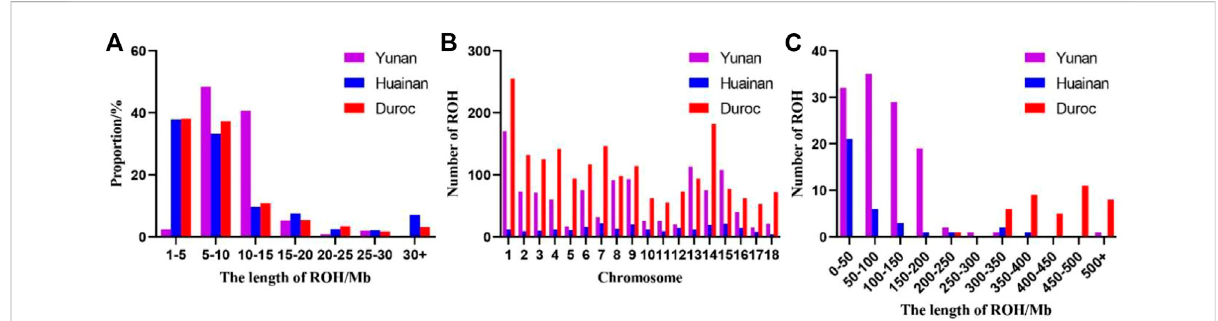
FIGURE 3 (A) Distribution of ROH length in Yunan, Huainan and Duroc. (B) Distribution of ROH quantity on Yunan, Huainan and Duroc chromosome. (C) Distribution of ROH samples number in Yunan, Huainan and